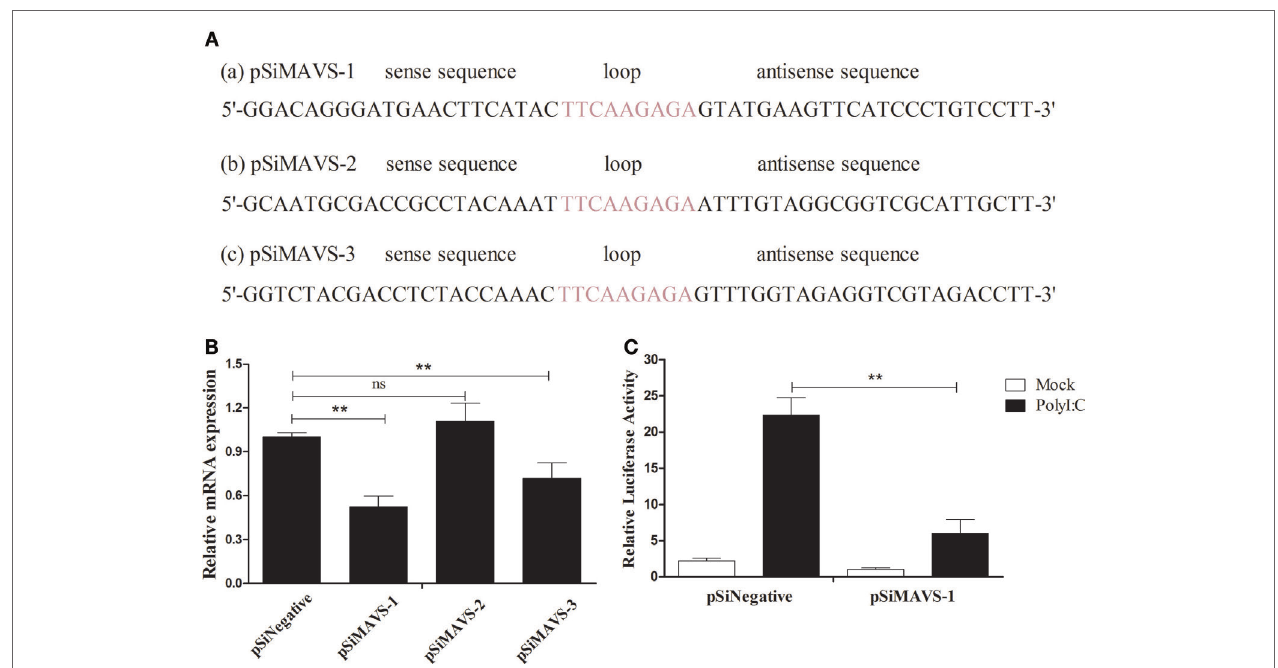
FigUre 7 | duMaVs knockdown decreases the polyi:c-stimulated induction of iFn- β . (a) Three siRNA sequences (a, b, and c) targeting the 111–131, 152–173, and 270–290 bp position of duMAVS were prepared, respectively. (B) The DEFs were seeded in 6-well plates and transfected with 2.0 μ g/well of siRNA. After 20 h of transfection, the cells were collected for the detection of duMAVS expression by RT-qPCR method. The expression of MAVS was first normalized to that of β -actin and then compared to that of the control cells. (c) The DEFs were seeded in 24-well plates, cotransfected with pSiMAVS-1 (500 ng/well), IFN- β -luc reporter plasmid (100 ng/well), and pRL-TK plasmid (50 ng/well). After 20 h of transfection, the cells were stimulated with polyI:C (500 ng/well) or remained normal for 12 h, cells were lysed for luciferase assays. Data were means from three independent experiments. Student’s t -test was performed to evaluate the differences. *Significant difference ( P < 0.05); **highly significant difference ( P <